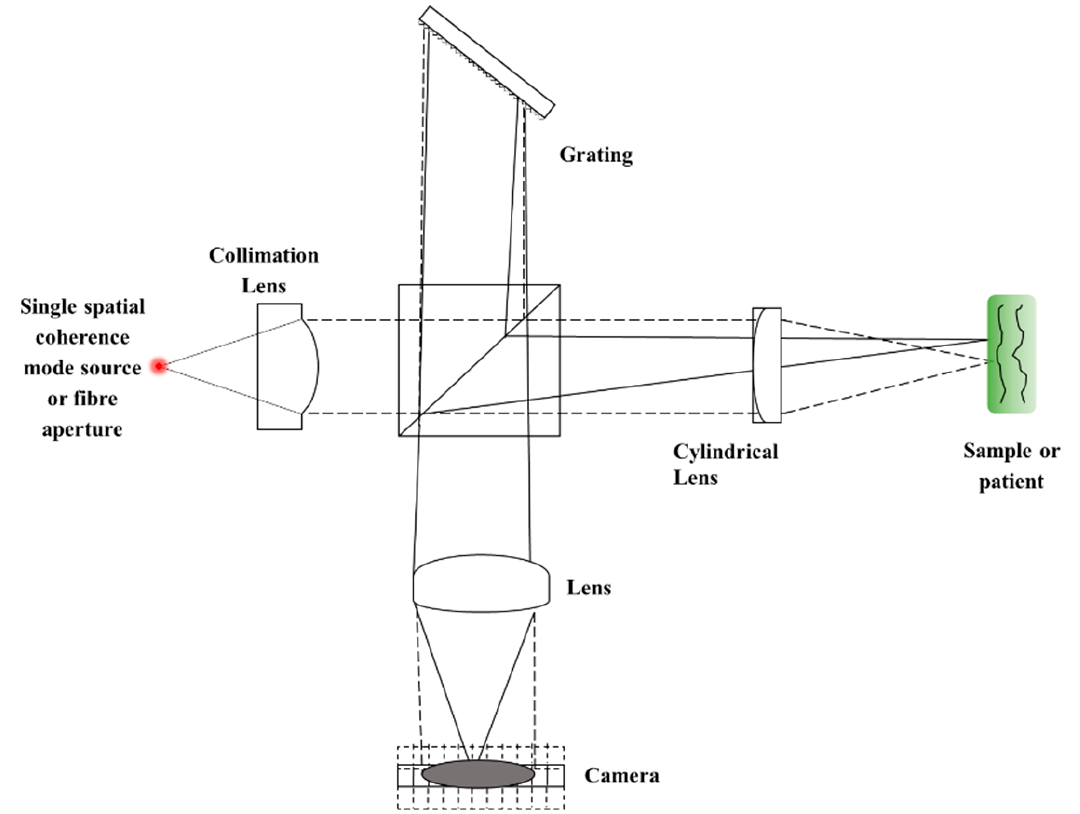
Figure 6. Generic schematic diagram of layout of LF-AL pseudo-OCT system.